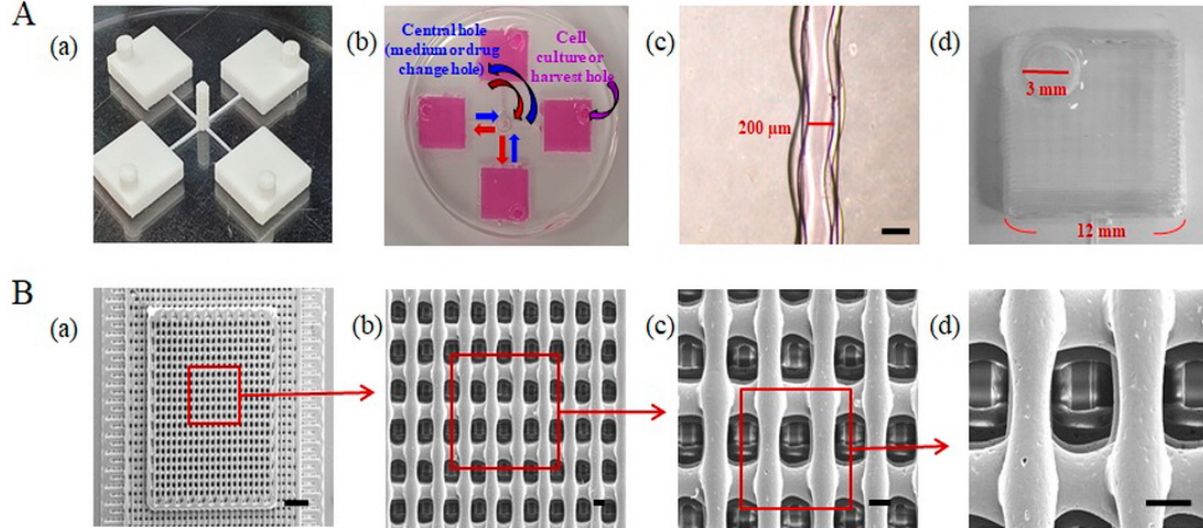
Figure 2. ( A ) Photograph and optical image of polycaprolactone (PCL) mold ( a ), polydimethylsiloxane (PDMS) multi- channel chamber ( b ), each channel ( c ), scale bar: 200 µm) and chamber ( d ). ( B ) Scanning electron microscope (SEM) images of the polycaprolactone (PCL) three-dimensional (3D) scaffold within PDMS multi-channel cell chip chip (a, scale bar: 1 mm). Partially magnified SEM image of the 3D scaffold ( b – d , scale bar: 100 µm).